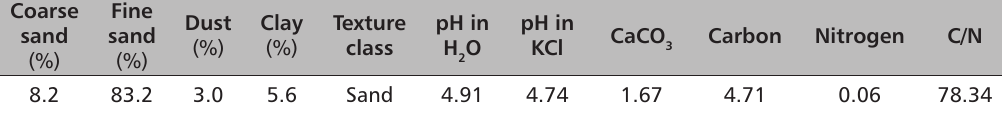
TABLE 1. Granulometric composition and some chemical properties of soil from Timok site Coarse sand